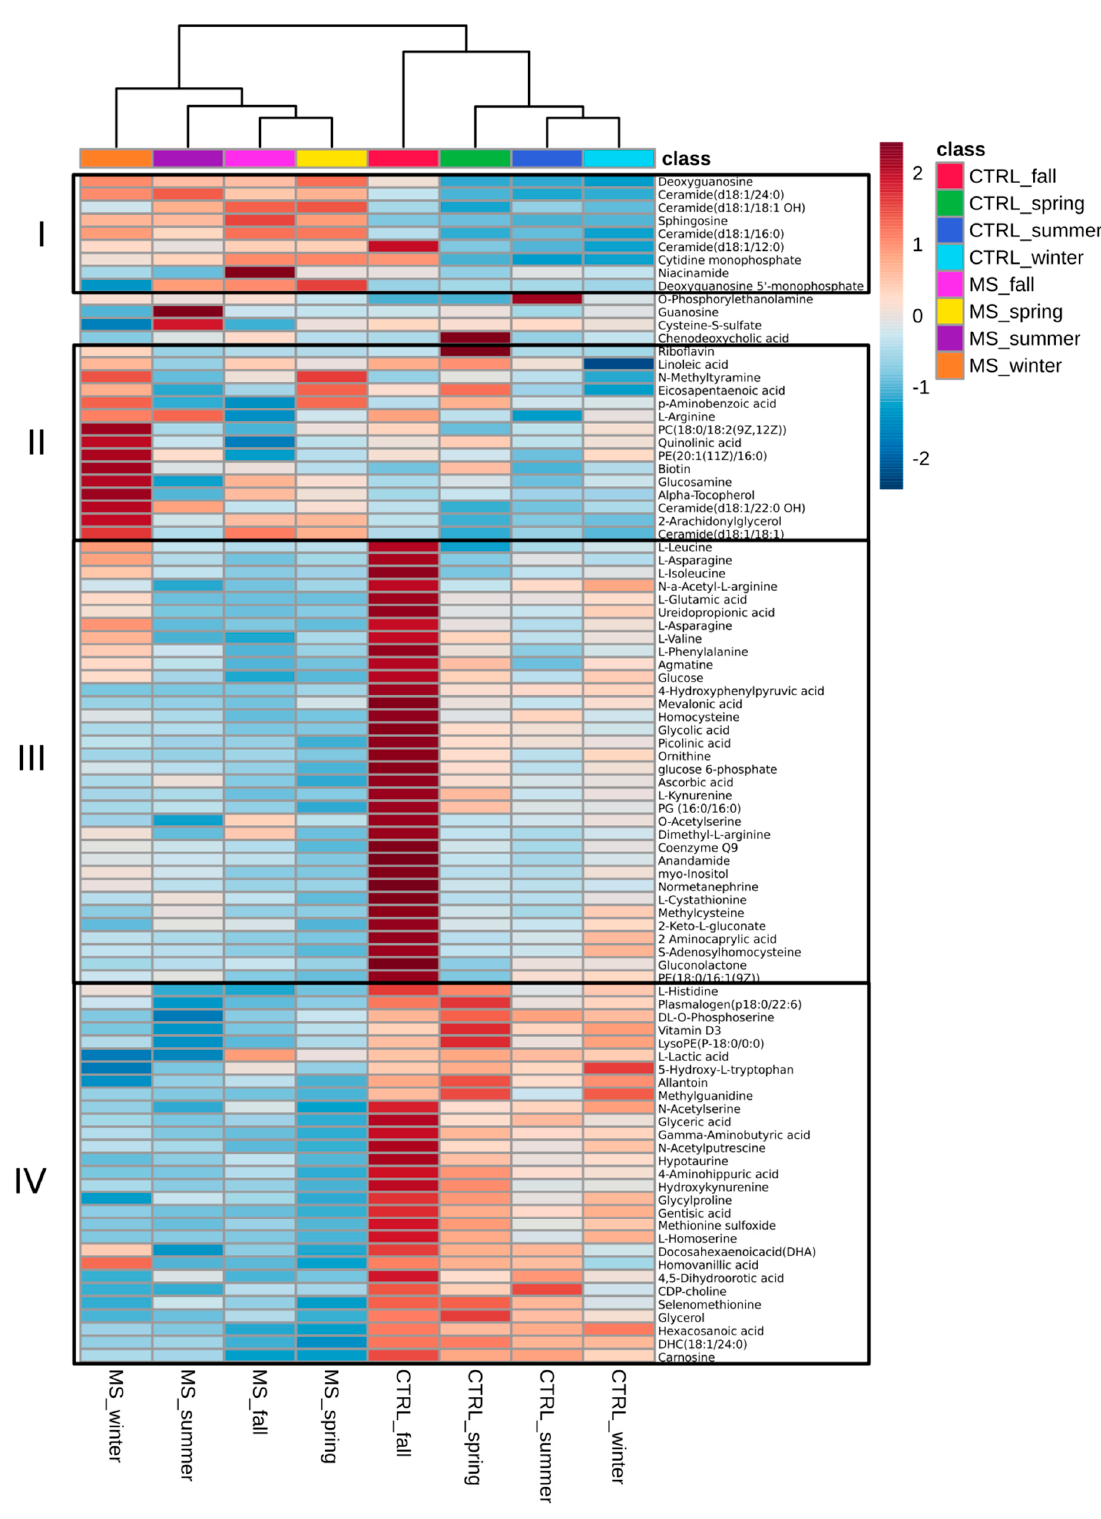
Figure 2. Heatmap analysis of metabolites in MS and control. Hierarchical cluster analysis was per- formed using Euclidean distance measure and Ward’s linkage clustering algorithm. Average values for each metabolite were used for analysis. Heatmap analysis is produced using MetaboAnalyst 5.0 (Available online: https://www.metaboanalyst.ca (accessed on 25 December 2022)). All presented metabolites differed significantly between at least one comparison group (p adj. < 0.05, one-way ANOVA with Fisher’s LSD).